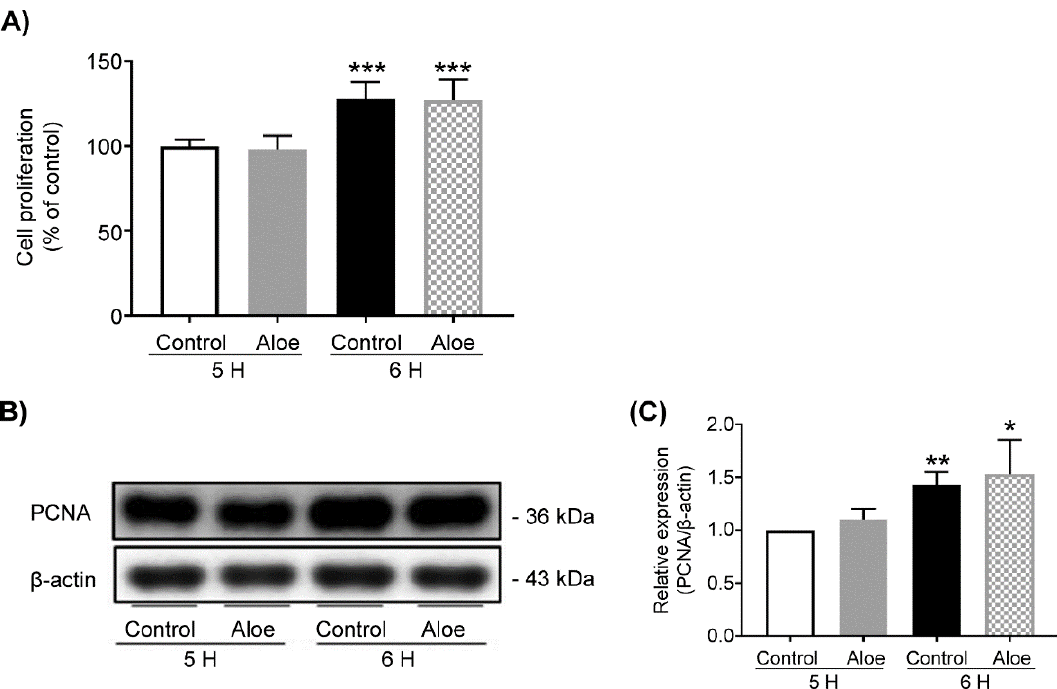
Figure 2. Effects of Aloe (AV) on the cell proliferation and PCNA protein expression in FRTL-5 cells. Cells were treated with 10 μ g/mL AV in both 5H and 6H media conditions. Cell proliferation ( A ) and PCNA protein expression were measured, and densitometric analysis of PCNA was performed ( B , C ). Data were represented as means ± SD ( n = 3); * p < 0.05, ** p < 0.01, *** p < 0.001 versus 5H control.